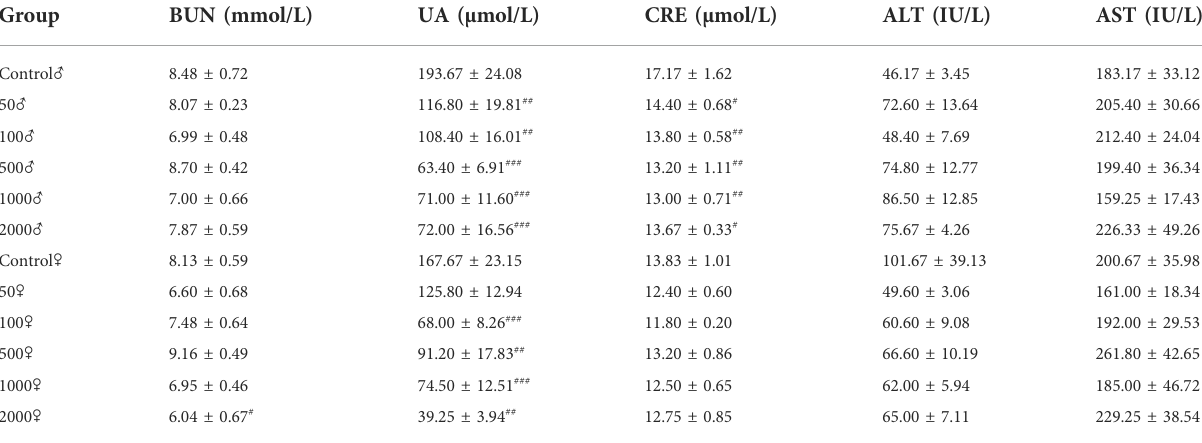
TABLE 2 Effect of NAY on serum biochemical indices of